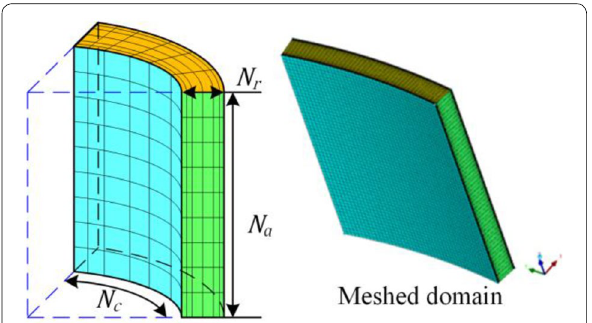
Figure 3 Mesh parameters and generation